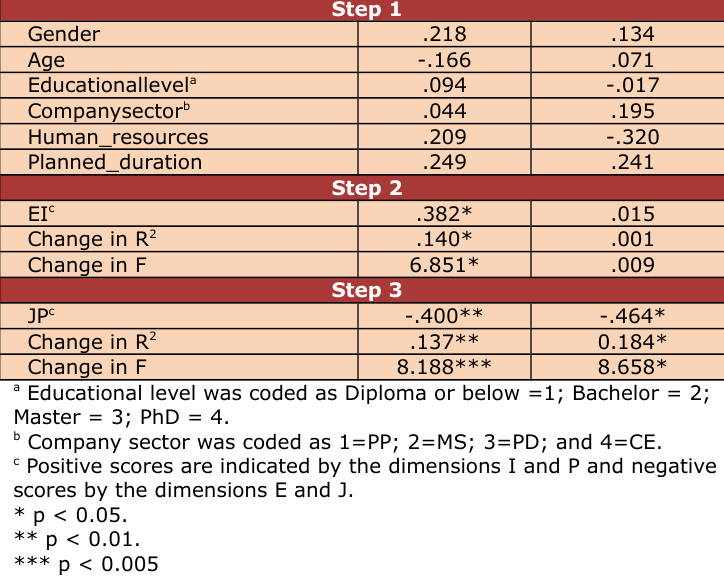
Table 6. Effect of EI and JP on traditional performance